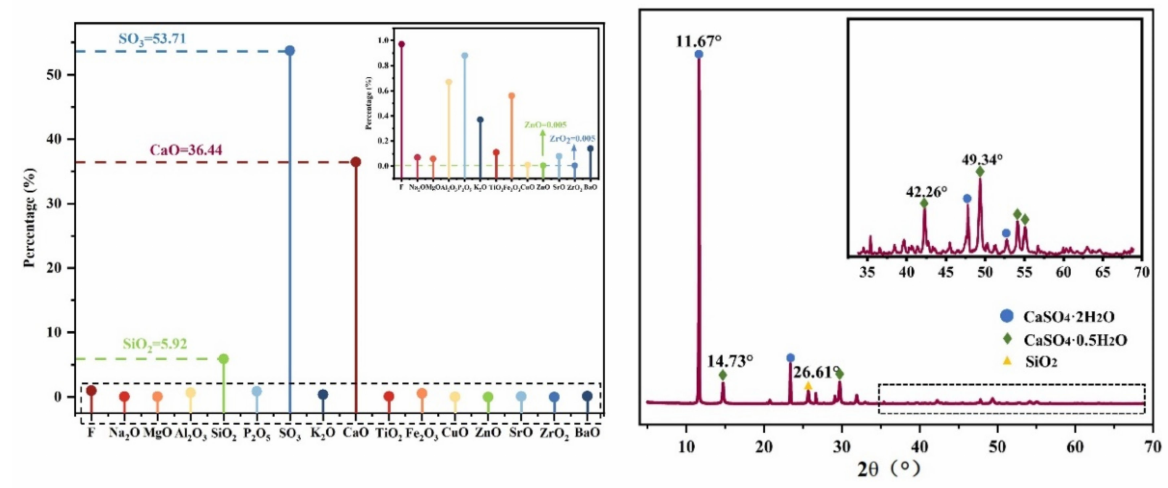
Figure 3. XRD and XRF patterns of phosphogympsum.